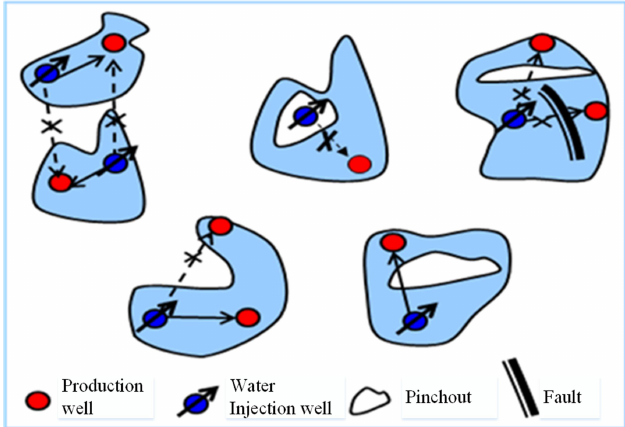
Figure 1—Injection-production relations influenced by single sand body forms, pinchout and faults